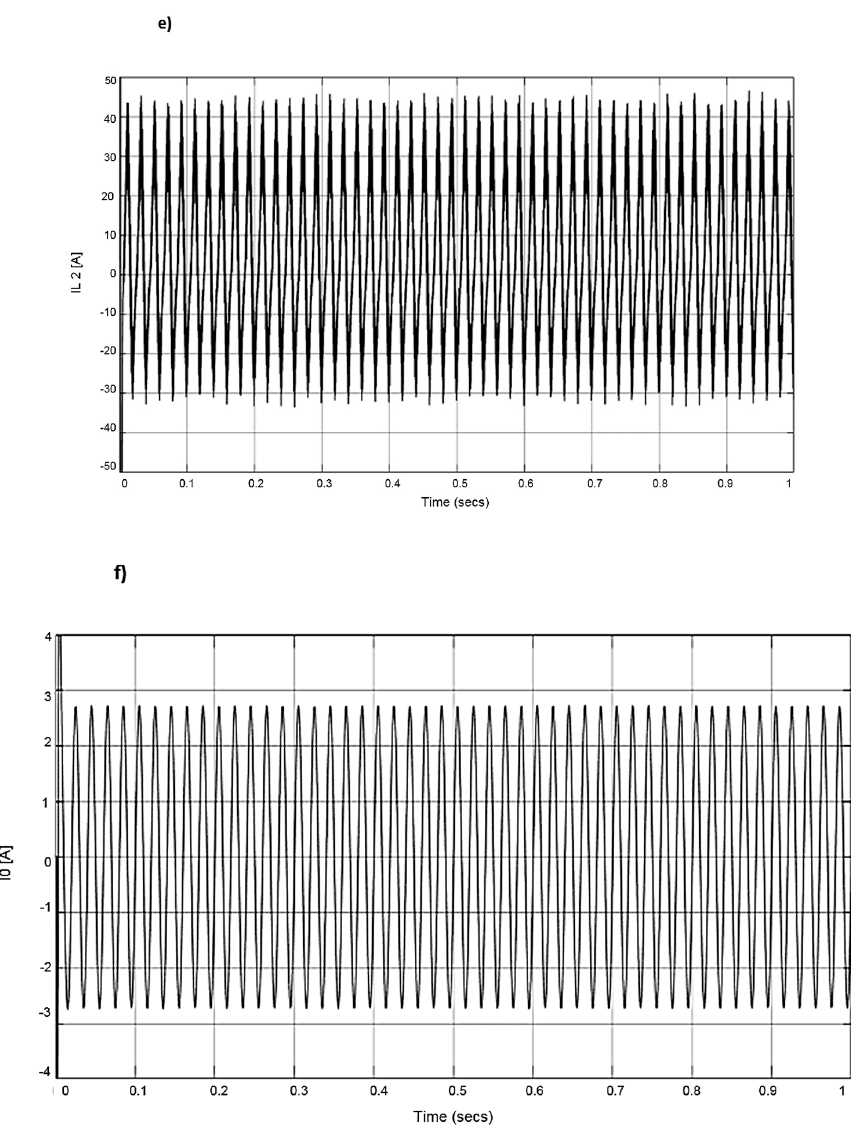
Figure A2. The performances (courses of voltages V 0 , V 1 , V 2 , and currents I L1 , I L2 , I 0 versus time) for the Li-S battery cooperating with the boost inverter. ( a ) V 0 ; ( b ) V 1 ; ( c ) V 2 ; ( d ) I L1 ; ( e ) I L2 ; ( f ) I 0. The courses of voltage V 0 , currents I 0 , I L , and voltages V c , V d , vs. versus time obtained from the